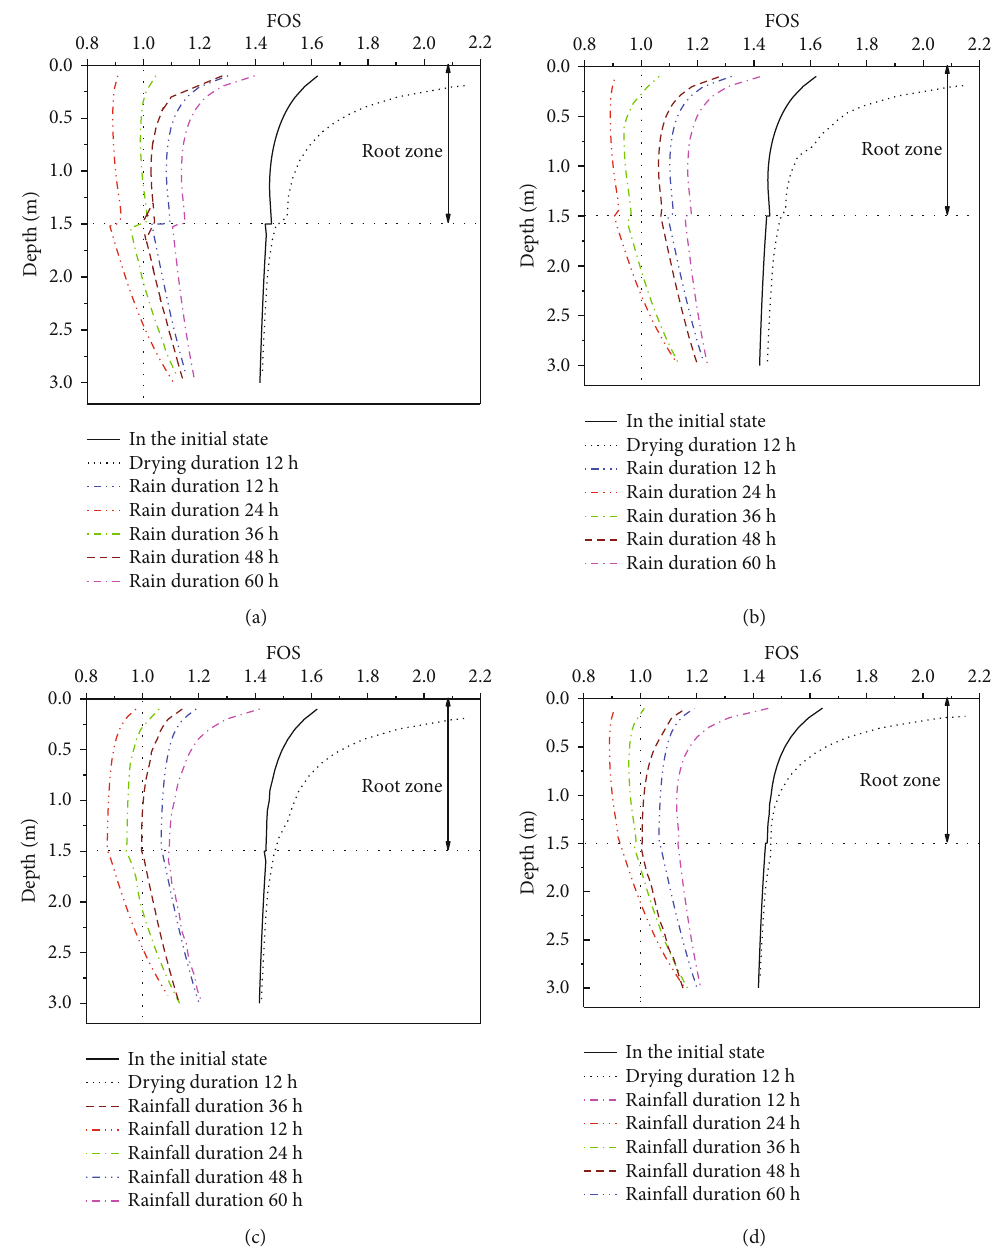
Figure 6: The FOS of di ff erent root architectures for rainfall amount of 500mm with di ff erent depths: (a) uniformly, (b) exponential, (c) triangular, and (d)